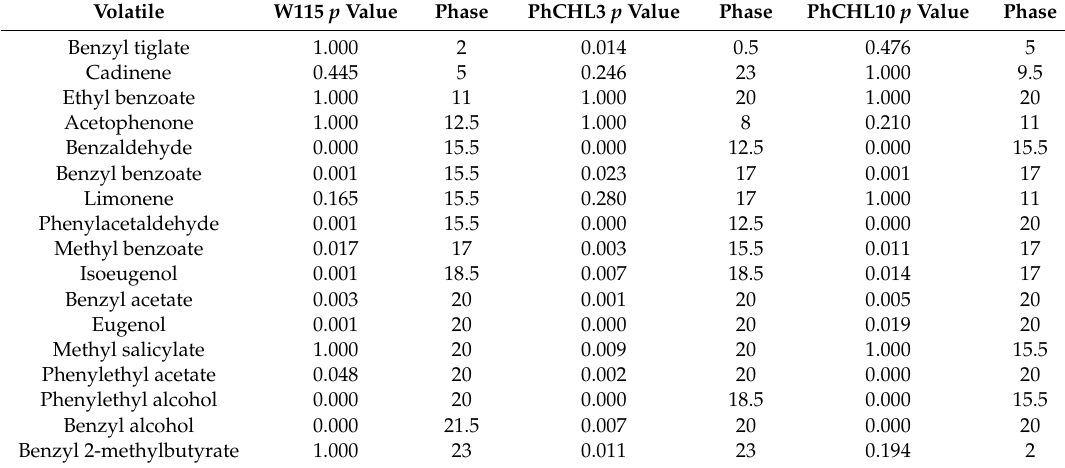
Table 4. Analysis of emitted volatiles with MetaCycle. The JTK_CYCLE algorithm implemented in the R library “MetaCycle” was used to detect rhythms in emitted volatiles of petunia wild-type (W115) and transgenic RNAi:PhCHL lines ( PhCHL3 , PhCHL10 ). Volatiles with significant p value ( p value < 0.05) showed a rhythmic emission. Phase is defined as the time point, in ZT h, with the highest